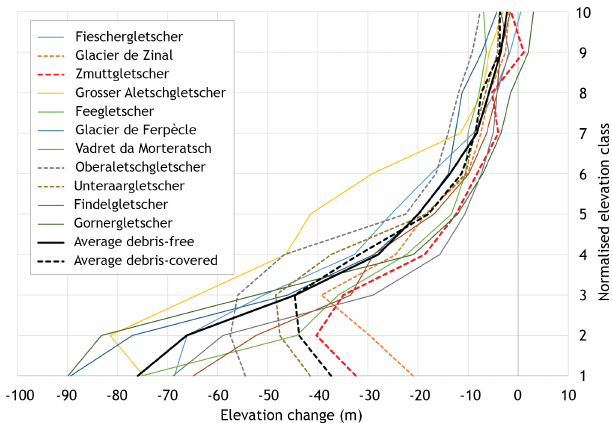
Figure 13. Elevation change between 1980 and 2010 against normalised elevation for a selection of Swiss glaciers. Solid lines: mostly debris-free glaciers; dashed lines: debris-covered glaciers. Data from Fischer et al. (2015). The lowest section of Aletschgletscher (yellow line) is actually also slightly debris cov-